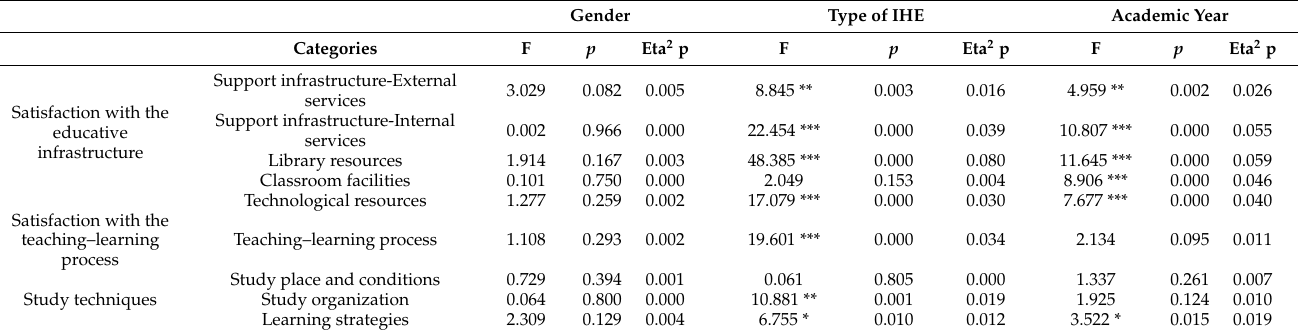
Table 4. Analysis of variance in each category according to gender, type of IHE and academic